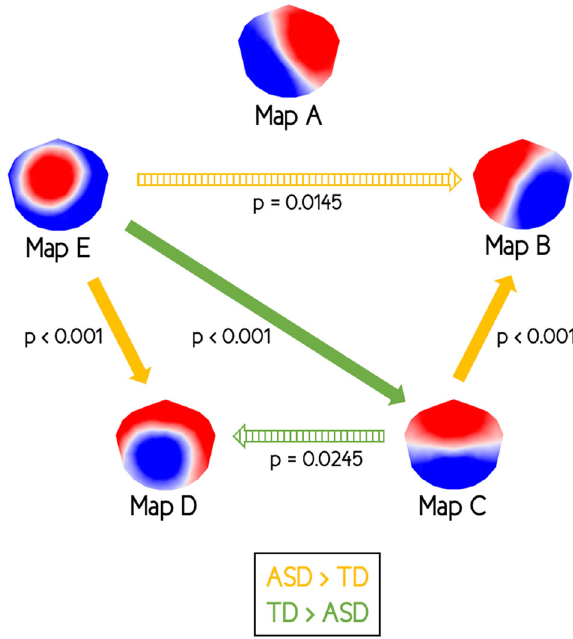
Fig. 6 Dynamic syntax results using Markov chains. Comparison of the transition probabilities between autism spectrum disorders (ASD) group and typically developing (TD) group. Uncorrected p -values. Orange arrows: transition probabilities in ASD group > TD group; green arrows: transition probabilities in TD group > ASD group; full arrows: p -values that survive false discovery rate (FDR) correction for multiple comparisons; hatched arrows: p -values that do not survive to FDR